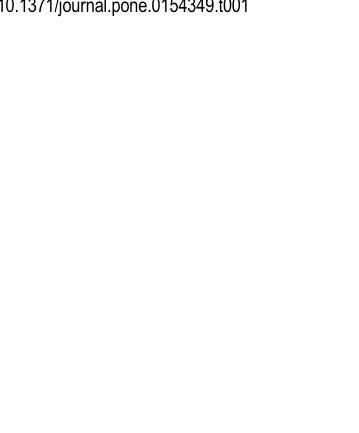
Length of both femurs or of the residual femur is reported with the consequent calculation of the height.